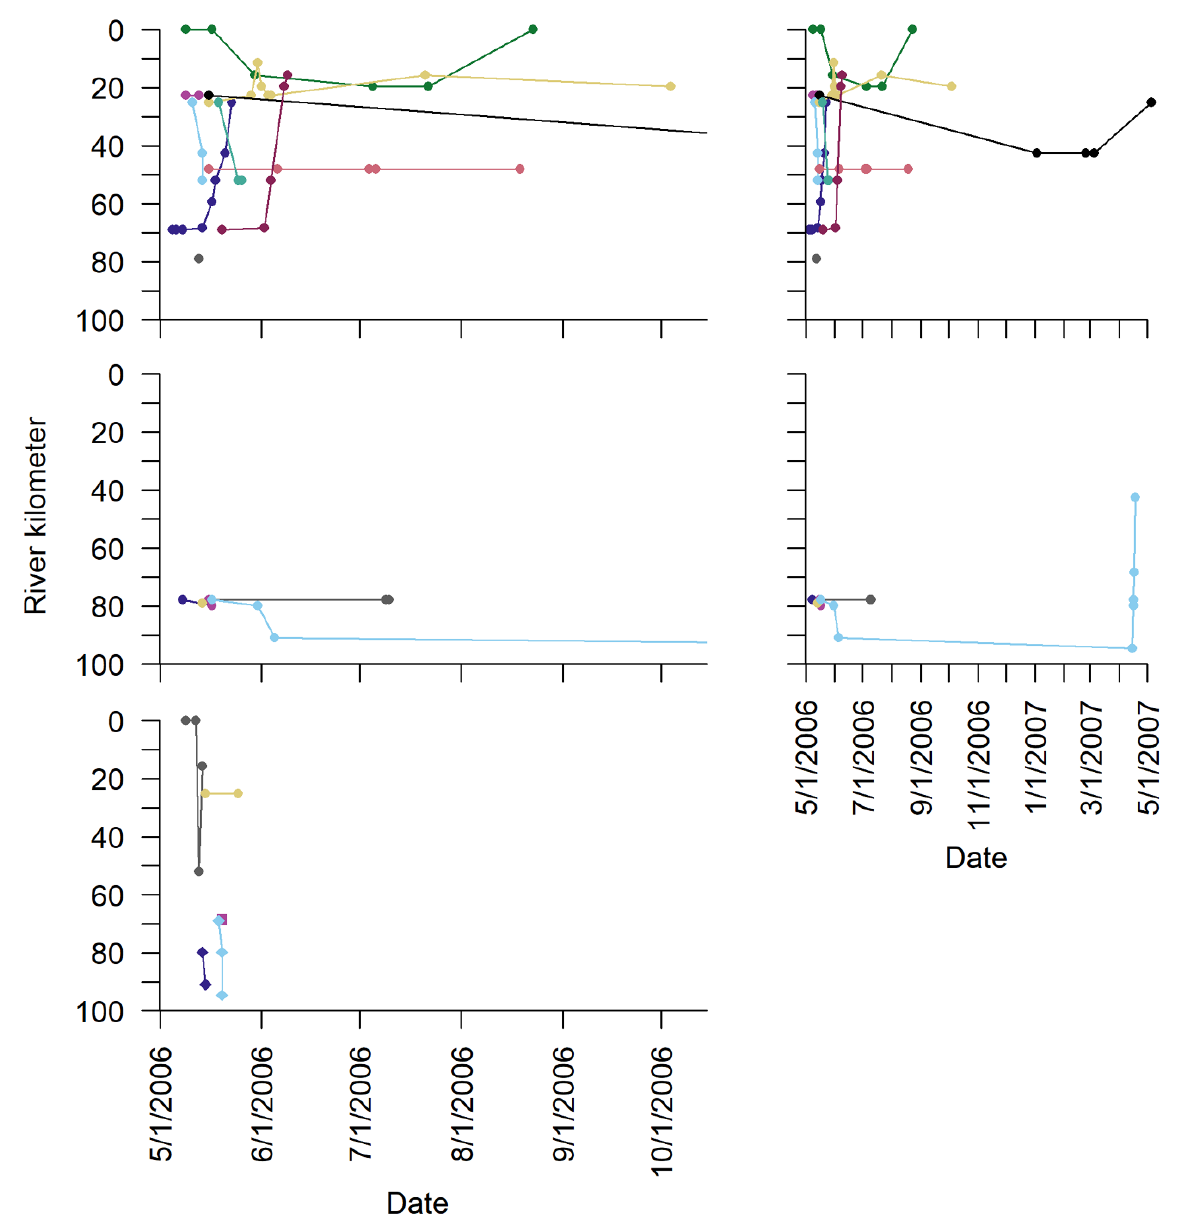
Figure 4. Movements of acoustic-tagged catfishes in the Mekong River, Thailand and Lao PDR. Each point represents a detection by an acoustic receiver. River kilometer corresponds to the location of the receiver within the study area, with zero being the location of the first receiver in the array, Golden Triangle (GTR), which is also the most upstream receiver. The panels on the right show the same data as the panels on the left, but with the dates extended through 5/1/2007 to show the full datasets for two fish monitored for nearly one year. Top panels: B. yarrelli ; middle panels: H. wyckioides ; bottom panel: W. attu (circles), P. bocourti (diamonds), and P. conchophilus (square).